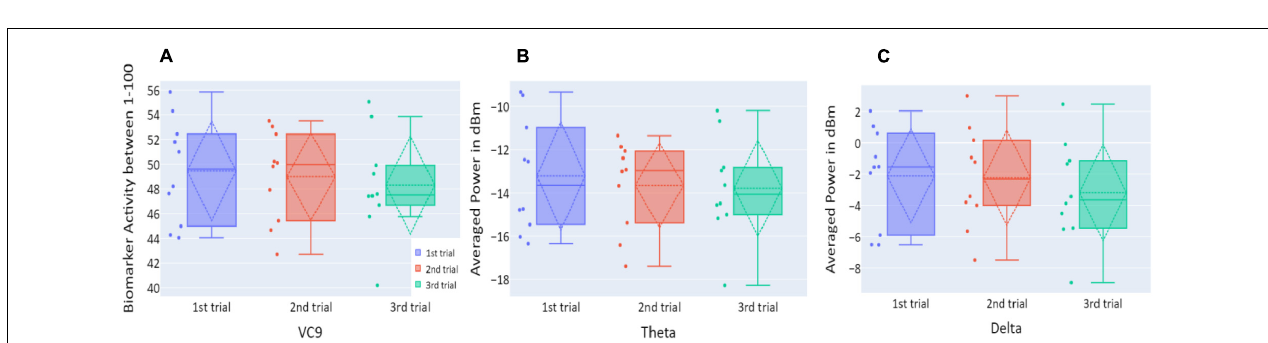
FIGURE 5 | The means of accuracy (in percentage), economy of movement (in percentage), and time to exceed the task (in seconds) obtained in the three trials of Experiment 2, as a function of task repetitions: first trial (blue), second trial (red), and third trial (green), for participants who underwent Experiment 2 ( n = 10). Error bars represent standard errors. ∗ p < 0.05, ∗∗ p < 0.01, and ∗∗∗ p < 0.001.